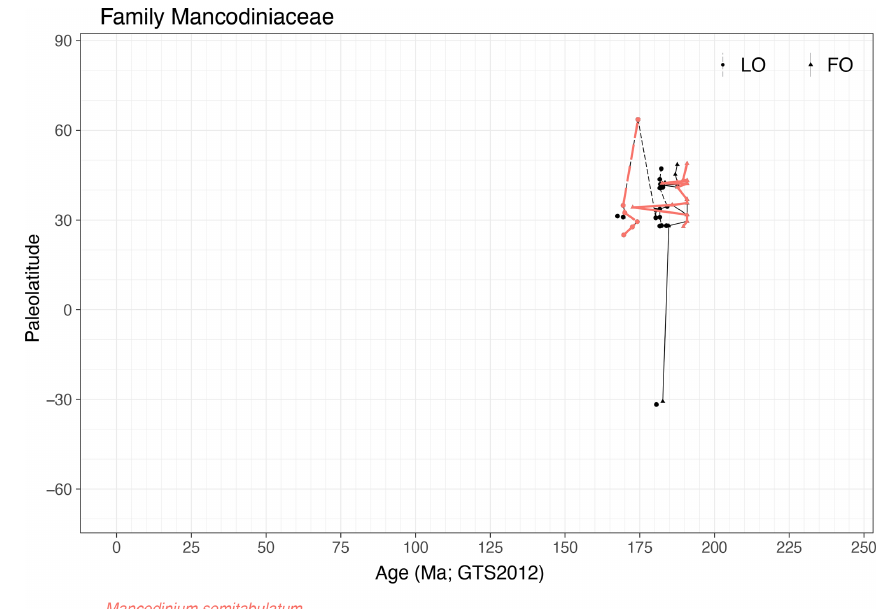
Figure 13. Same as Fig. 5 but for the family Mancodiniaceae.